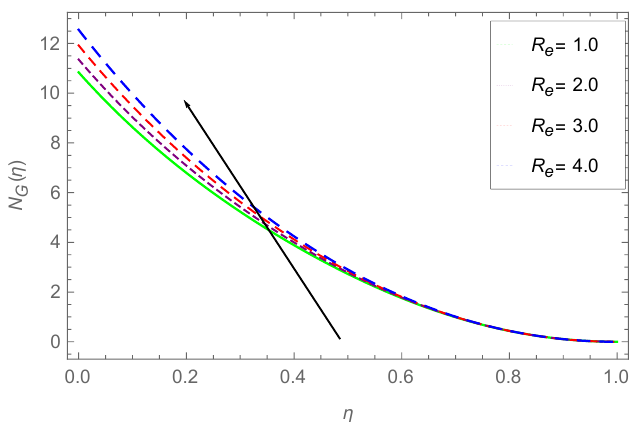
Figure 20. Variations in the function of entropy N G ( η ) for dissimilar values of R e , when Br = 0.1, Rd = 0.6, M =